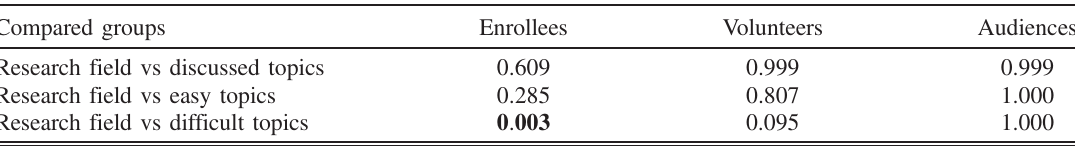
Bold indicates significant results ( p ≤ 0 . 05